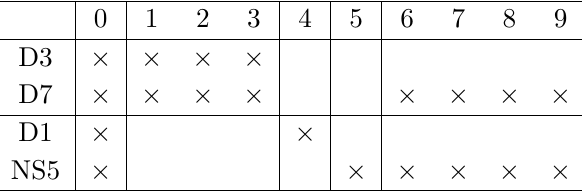
Table 1 . The directions in which branes extend are indicated by (cid:2)